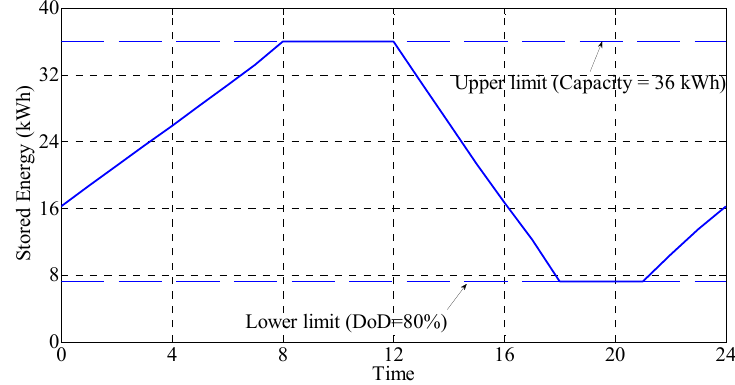
Figure 14. Case Study 3: Energy stored by the DESS at bus no.37 during the last typical day.